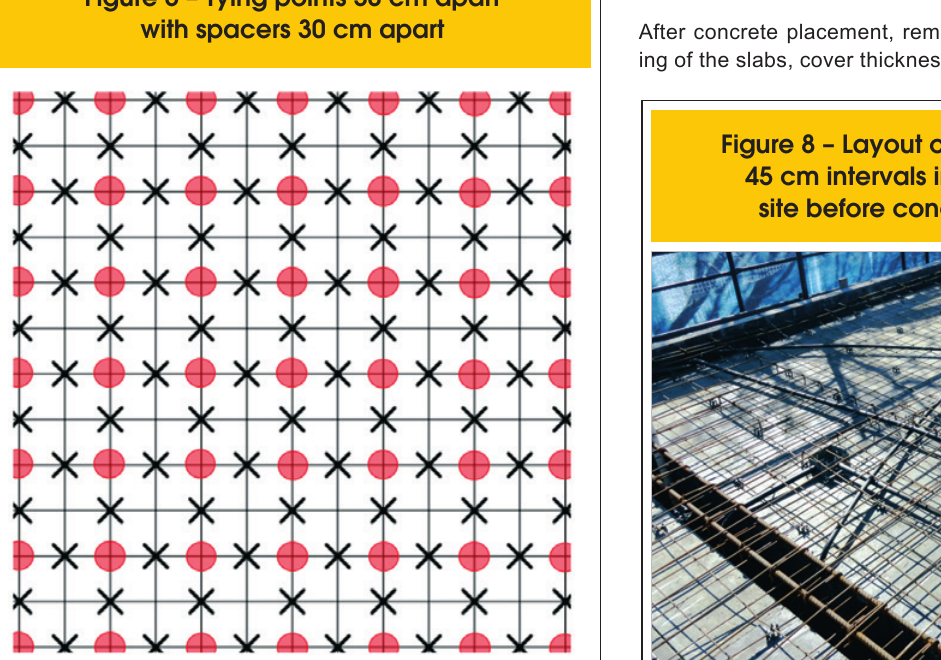
Figure 6 – Tying points 30 cm apart with spacers 30 cm apart